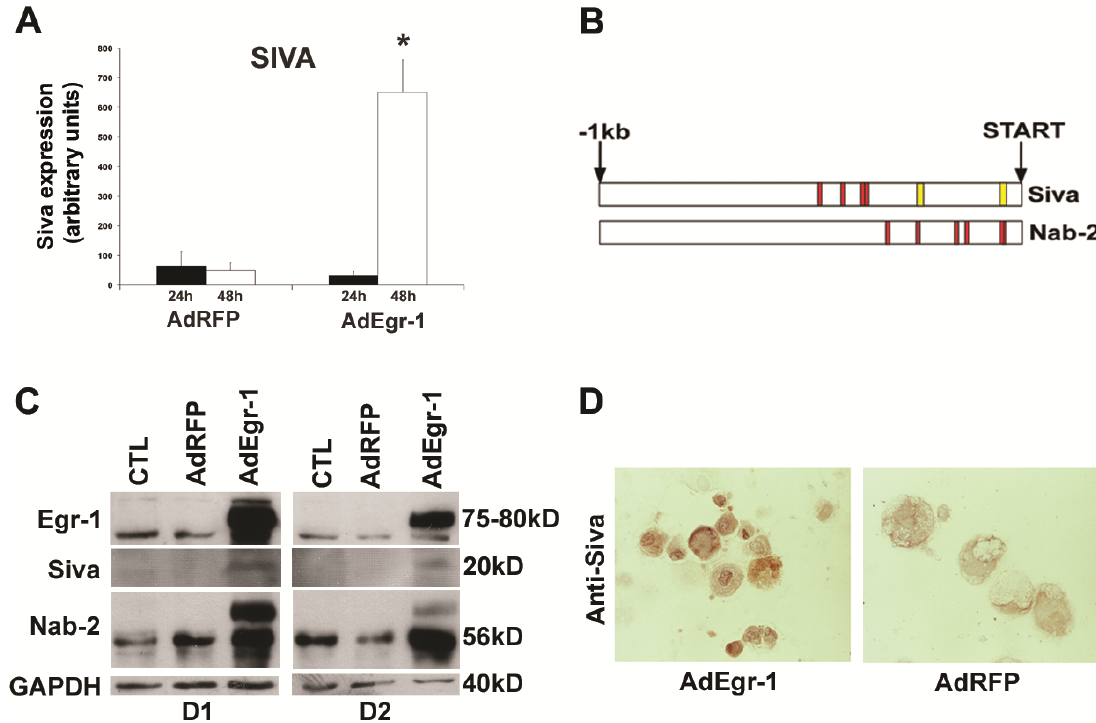
Figure 3. AdEgr-1 induces downstream target gene expression in cardiac fibroblasts. (A ) In cardiac fibroblast cultures, monitoring mRNA levels of Siva-1 mRNA by real time RT-PCR 24 and 48 h post-infection with AdEgr-1 and AdRFP controls showed transient induction of Siva-1 mRNA after 48 h. Levels of all transcripts were normalized against B2M. Values incorporate the standard deviation of three experiments ( * p <